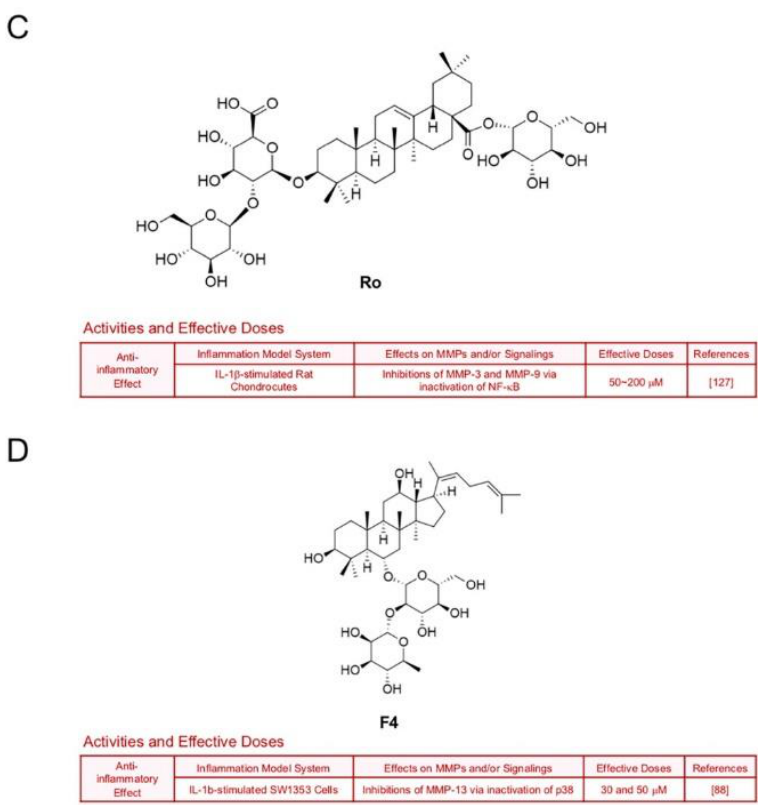
Figure 11. Summary of activities of ginsenosides Rg5, Rb3, Ro and F4. Structures of Rg5 ( A ), Rb3 ( B ), Ro ( C ) and F4 ( D ) and their effects on MMPs and/or signalings [88,125–127].